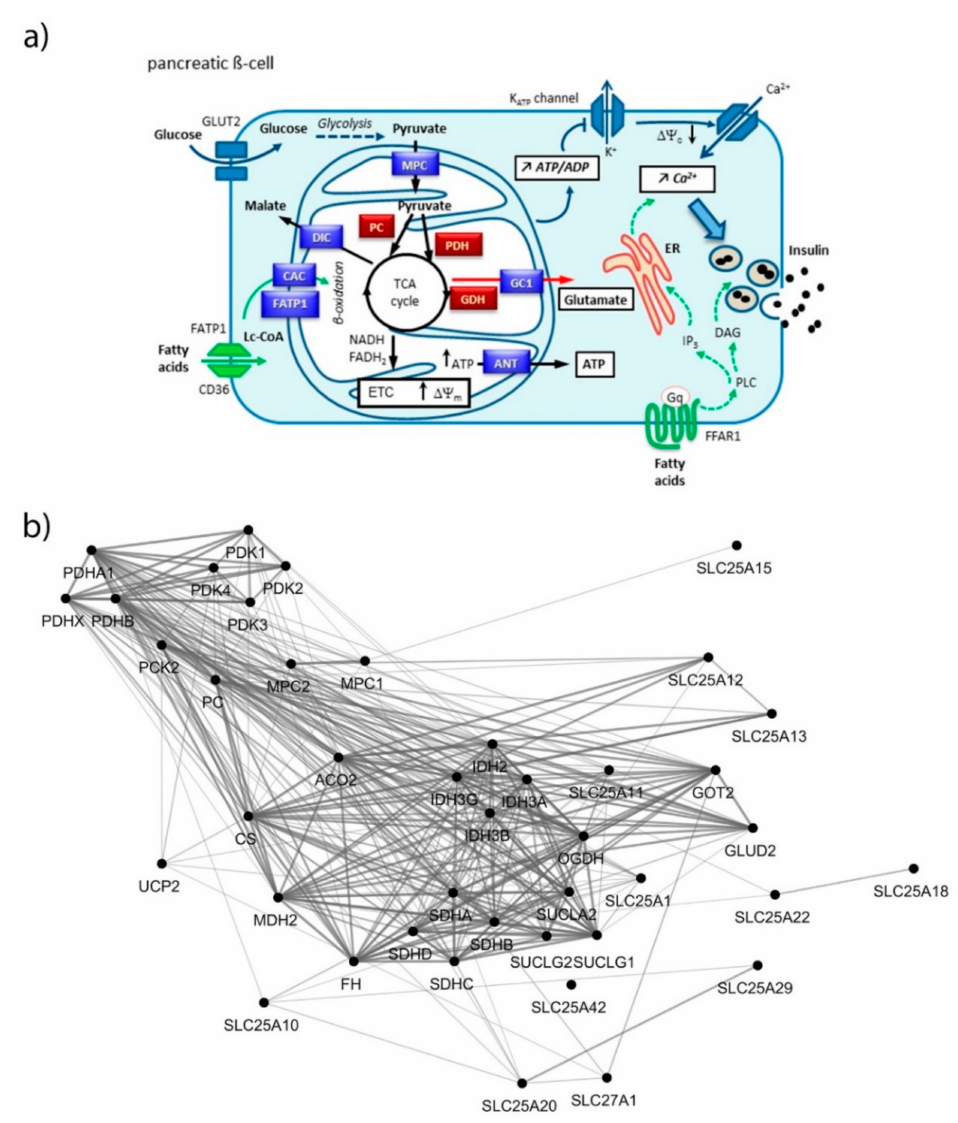
Figure 1. ( a ) Coupling of glucose metabolism with insulin secretion in pancreatic β -cell. Glucose is metabolized through glycolysis that produces pyruvate. Pyruvate enters into mitochondria through the mitochondrial pyruvate carrier (MPC) and fuels the TCA cycle by the action of both pyruvate carboxylase (PC) and pyruvate dehydrogenase (PDH). The TCA cycle generates reducing equivalents transferred by NADH and FADH 2 to the electron transport chain (ETC), leading to the hyperpolarization of the mitochondrial membrane ( ∆Ψ m ) and generation of ATP. Then, ANT transfers ATP to the cytosol, raising the ATP / ADP ratio that induces the closure of the K-ATP channels promoting plasma membrane depolarization ( ∆Ψ c ). This opens voltage sensitive Ca 2 + channels, increasing cytosolic Ca 2 + concentration ([Ca 2 + ] c ), which triggers insulin exocytosis (triggering pathway, blue arrows). The amplifying pathway of metabolism–secretion coupling is contributed to by additive coupling factors, e.g., glutamate produced by glutamate dehydrogenase (GDH) and transported by GC1 (red arrow). Free fatty acids potentiate glucose-stimulated insulin secretion through long-chain acyl-coenzyme A (Lc-CoA), glycerolipid / free fatty acid cycle (not shown), import into mitochondria through the fatty acid transport protein (FATP1) and the carnitine / acylcarnitine carrier (CAC), β -oxidation; or through FFAR1 signaling (green arrows). G α q activates phospholipase C (PLC) producing both inositol trisphosphate (IP3), which triggers calcium release from the endoplasmic reticulum (ER) stores, and raises diacylglycerol (DAG), an activator of the phosphokinase C (PKC) involved in insulin exocytosis. ( b ) Functional interaction network of mitochondrial metabolite carriers and associated genes, i.e., pyruvate metabolism, TCA cycle, amino acid metabolism and fatty acid transport. Nodes were connected using the STRING interaction knowledgebase with a confidence score >